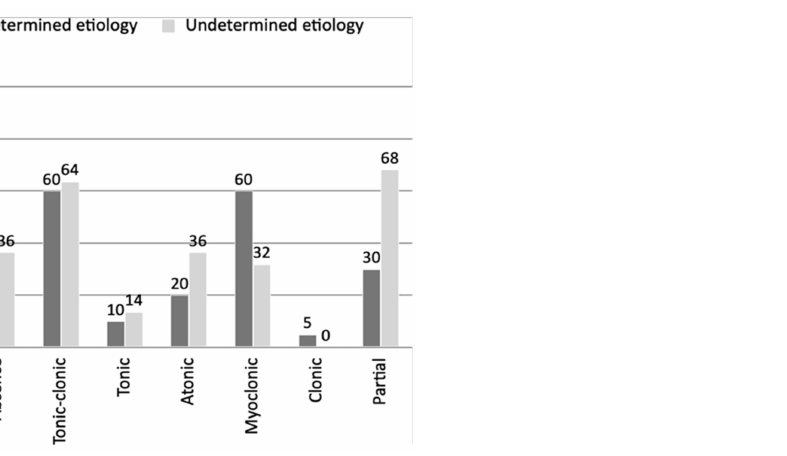
Figure 1. Percentage representation of the share of epileptic seizure types in groups with a defined and undefined genetic cause.